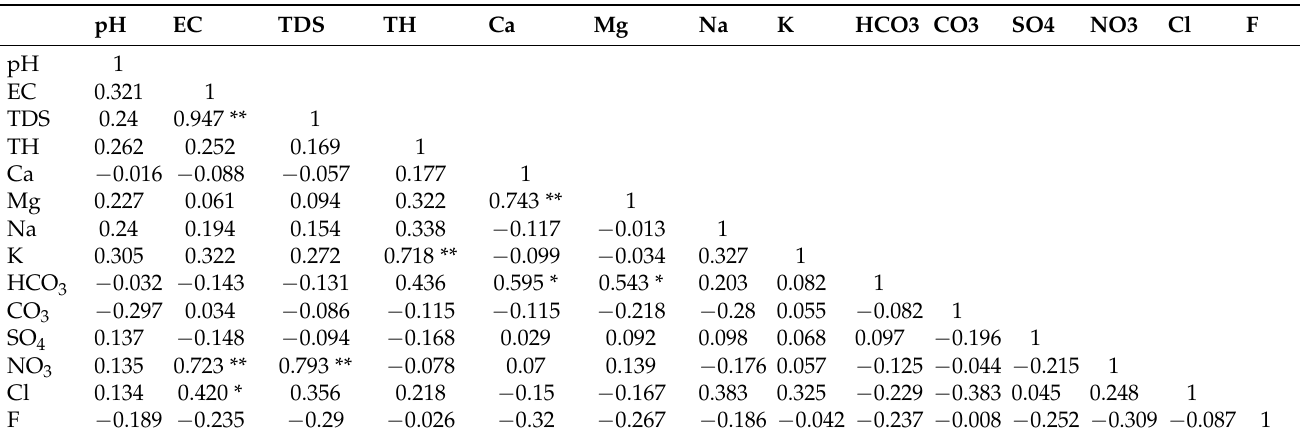
Table 4. The results of Pearson correlation